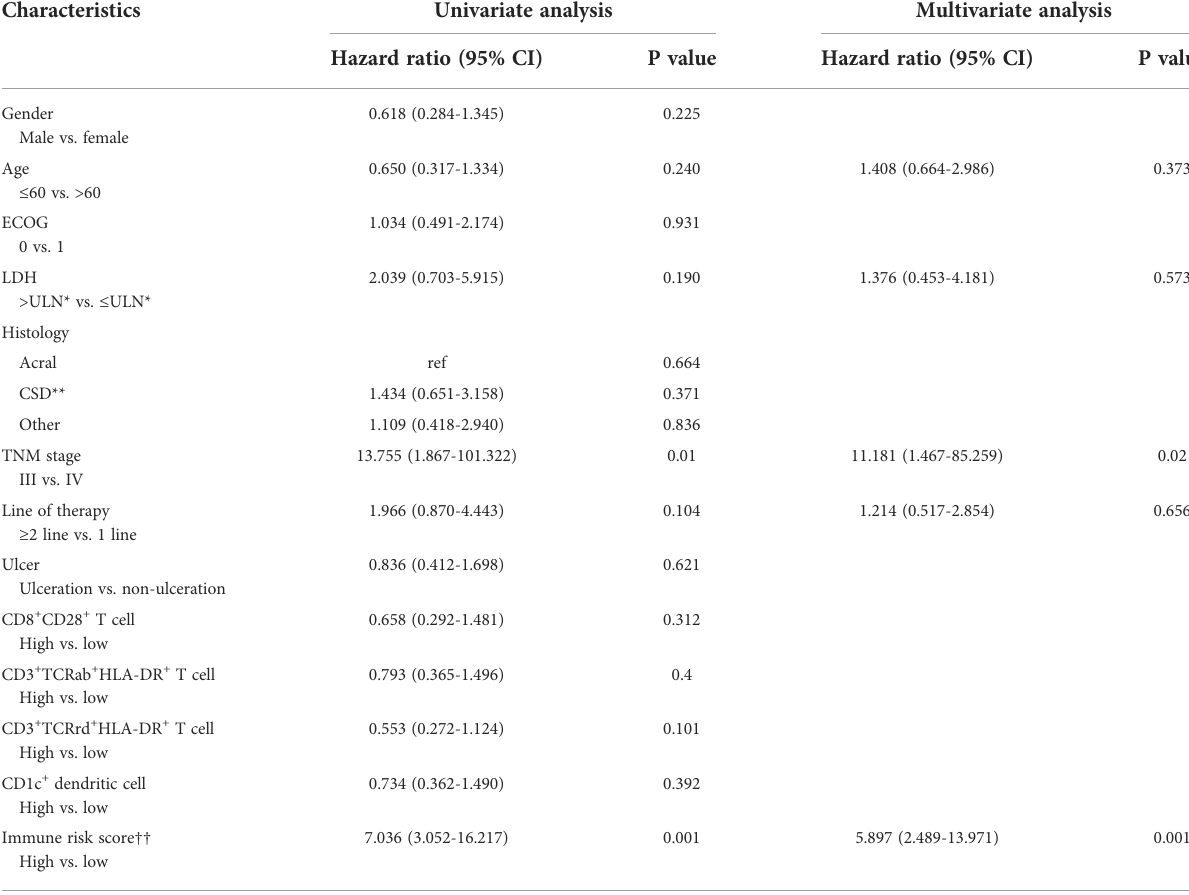
TABLE 2 Univariate and multivariate cox hazards analysis for progress-free survival in 49 patients with melanoma.